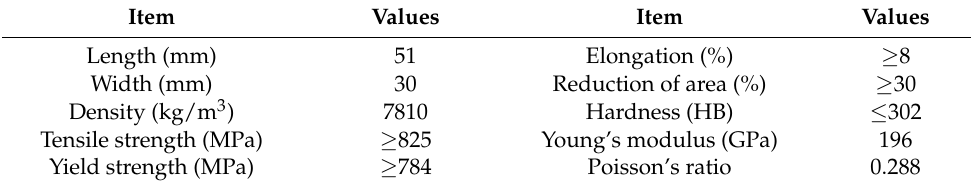
Table 3. Performance parameters of the flexure